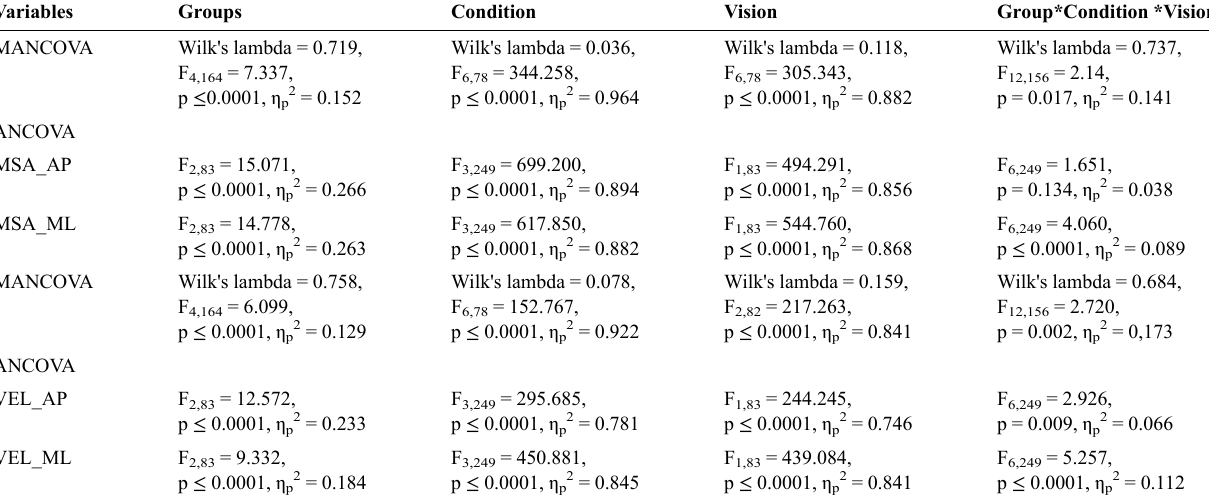
Table 2 - F, p, and η p2 values for the main effect and triple interaction between factors (group, condition, vision, and group*condition*vision) of MAN- COVAs and ANCOVAs for time variables: mean sway amplitude (MSA) and mean displacement velocity (VEL) of the center of pressure (COP) in the anteroposterior (AP) and mediolateral (ML)